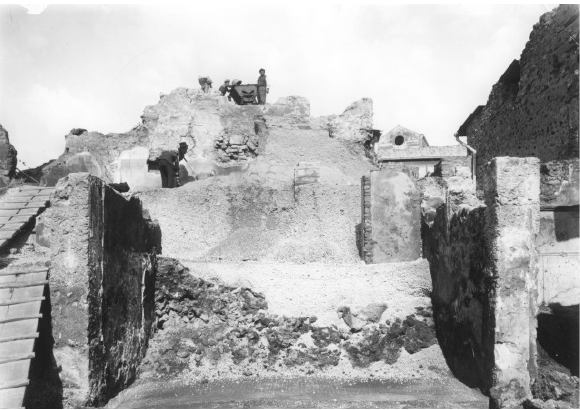
Figure 2. Historical photography of the excavation of 1926